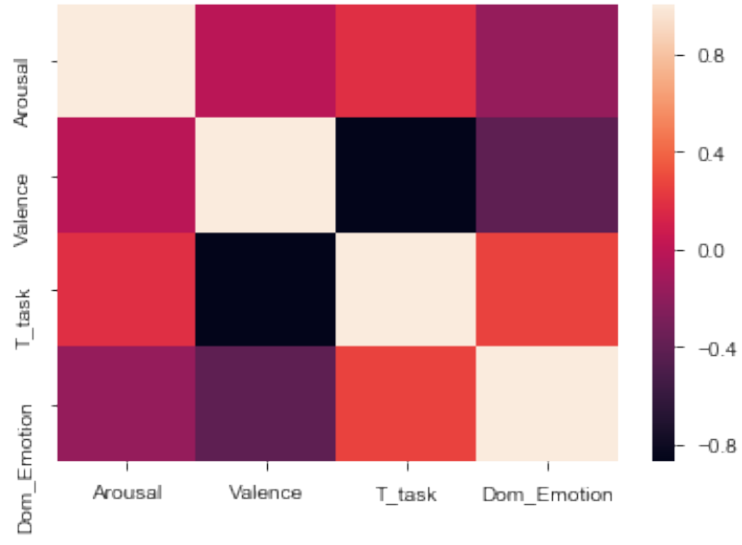
Figure 9. Correlation